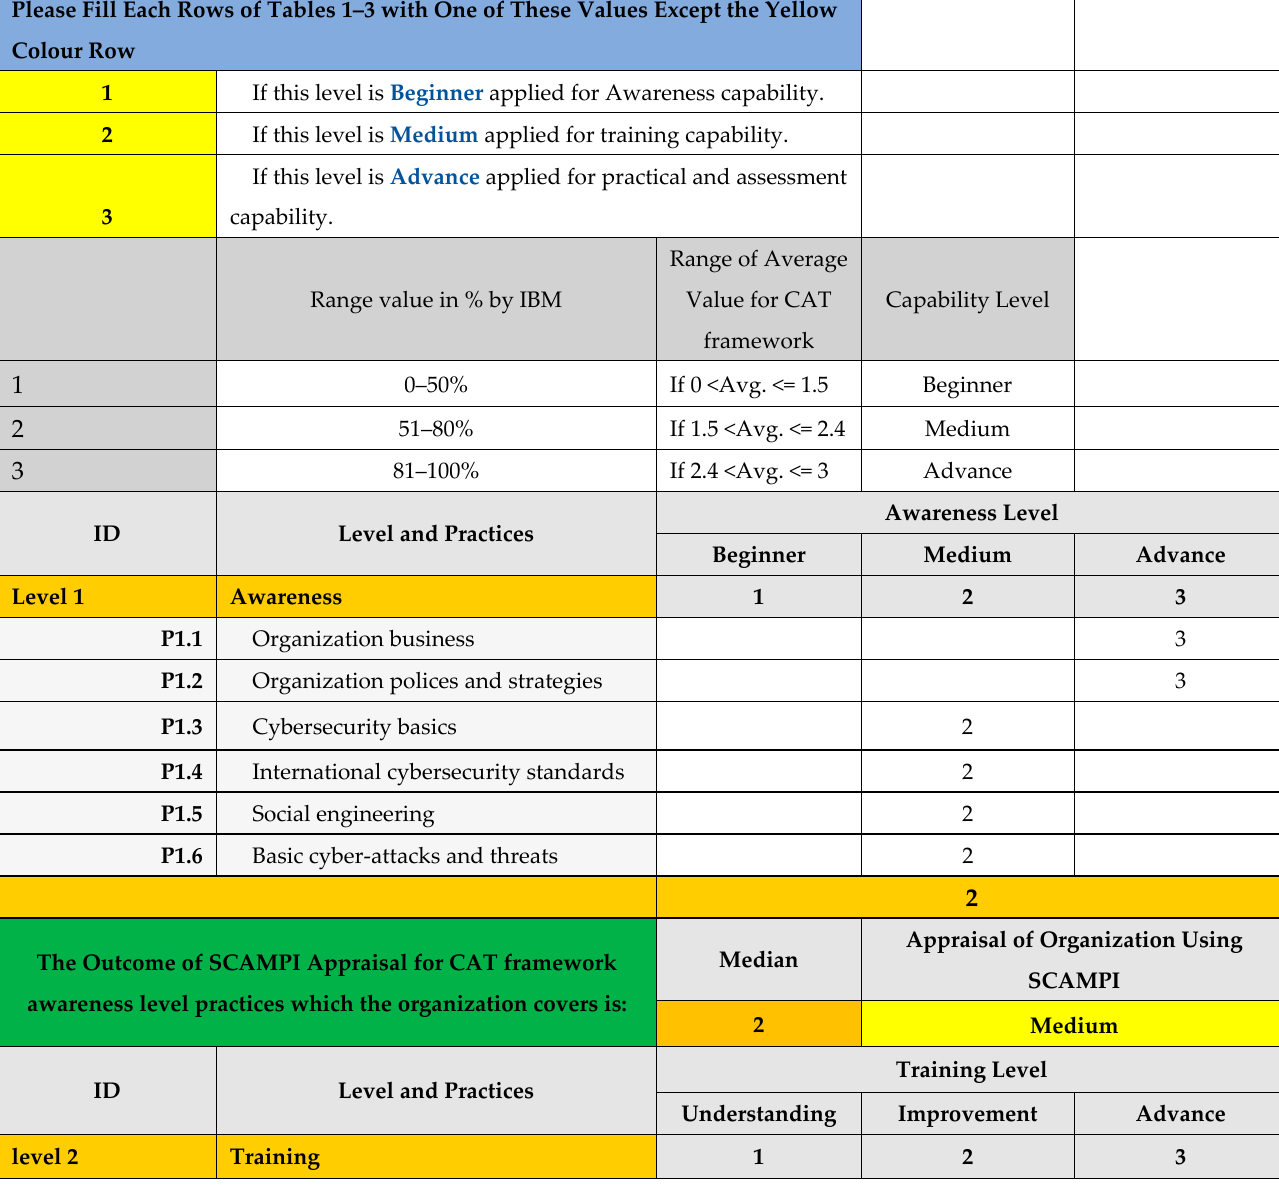
Table A1. Case Study Excel Sheet Example of an Anonymous